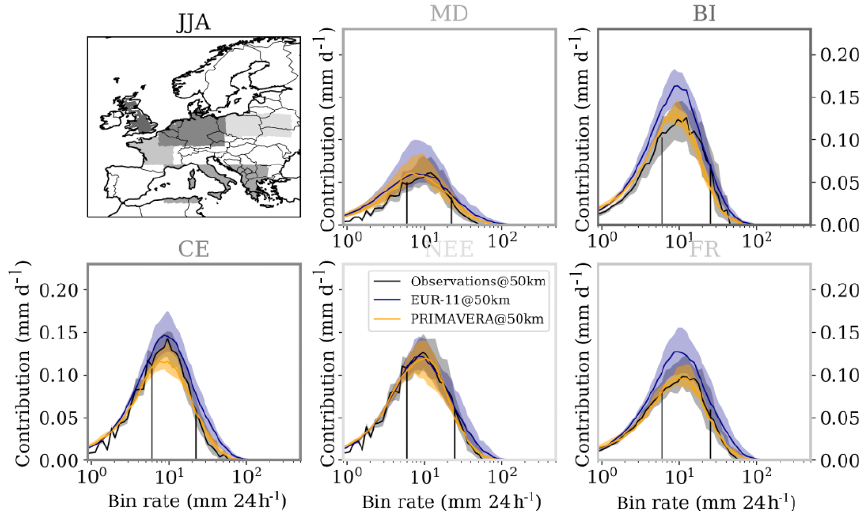
Figure 7. Same as Fig. 6 for